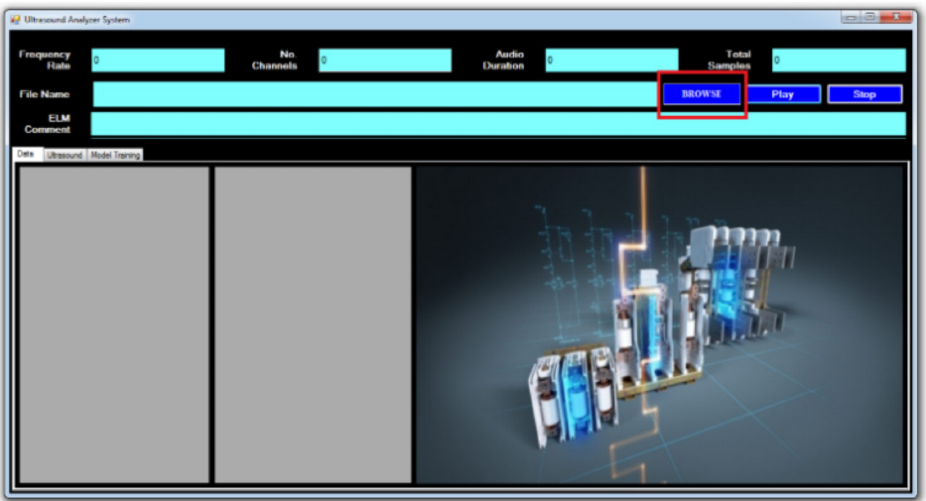
Figure 7. Ultrasound Analyzer System